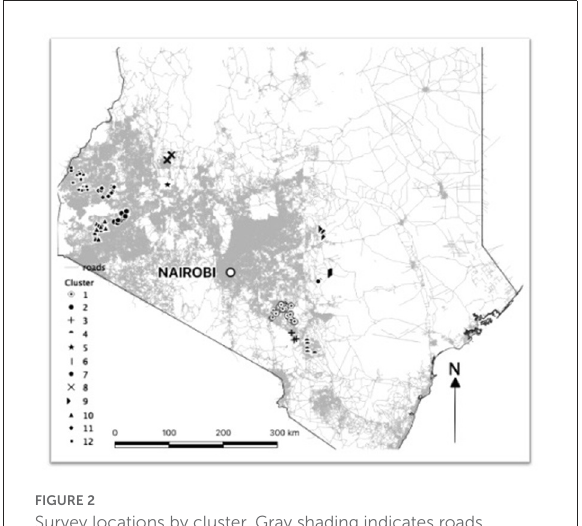
FIGURE2 Survey locations by cluster. Gray shading indicates roads. Symbols indicate survey locations and